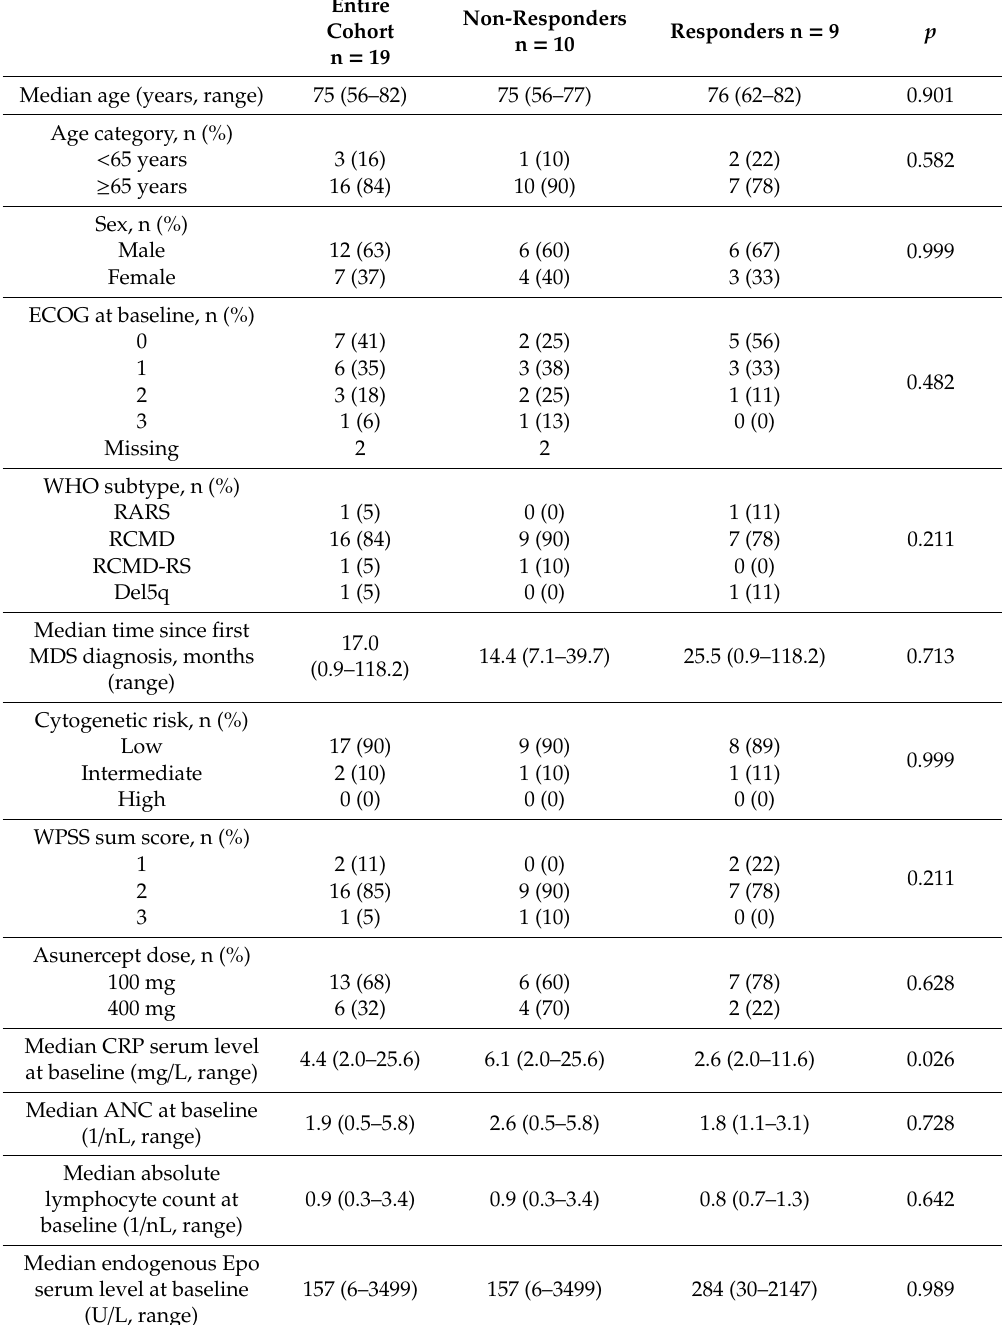
Table 1. Patient characteristics according to treatment